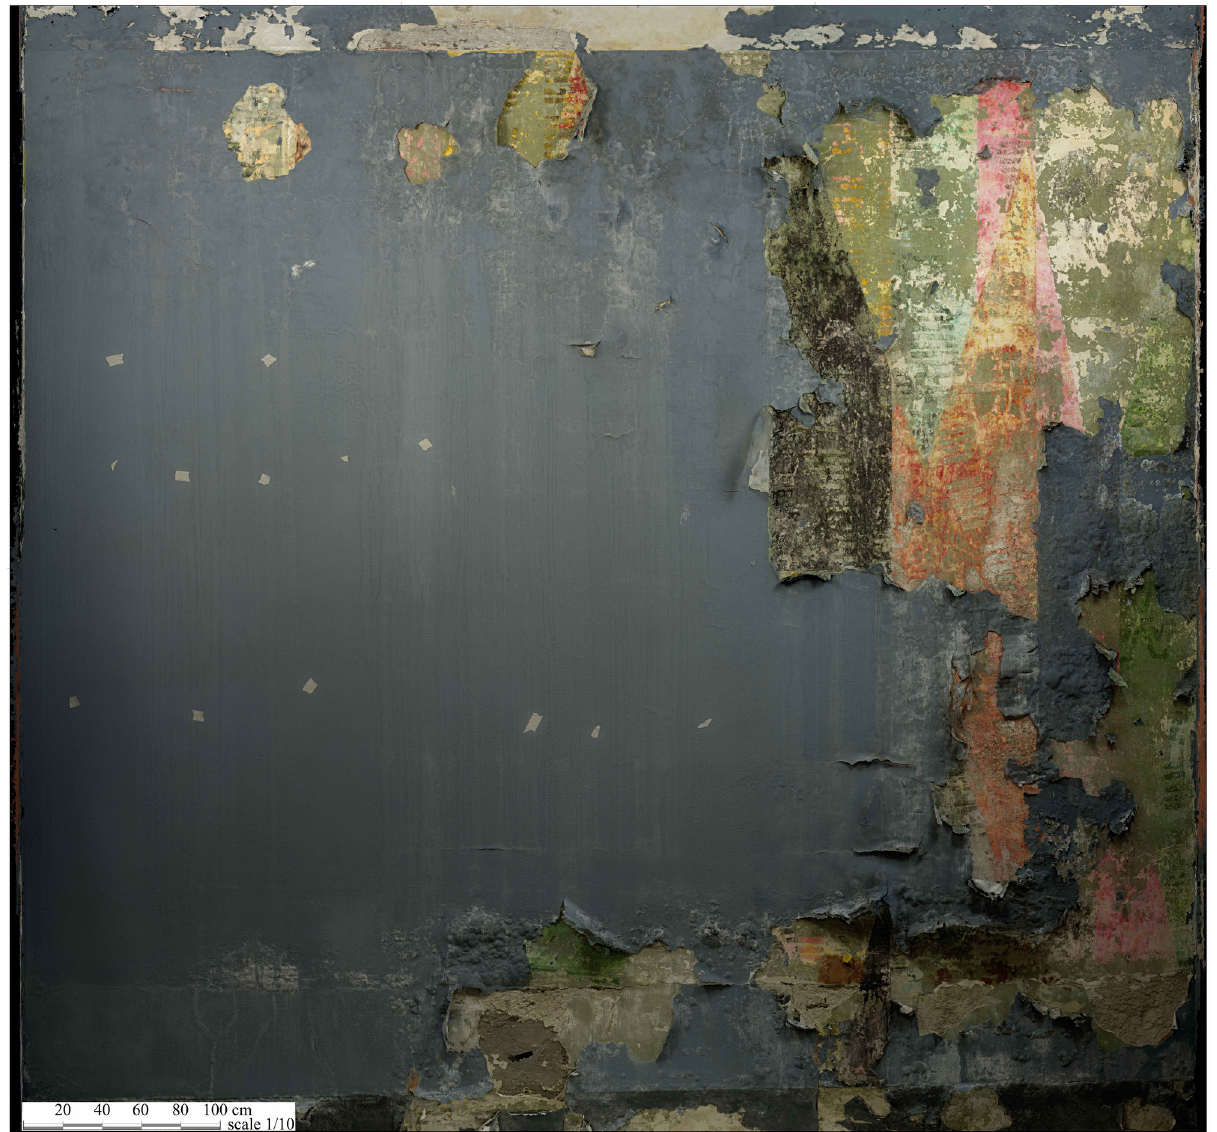
Figure 1 . Orthophoto of the lower ceiling of the Capogrossi wall painting at the Airone cinema. Image: Paola Mezzadri all rights